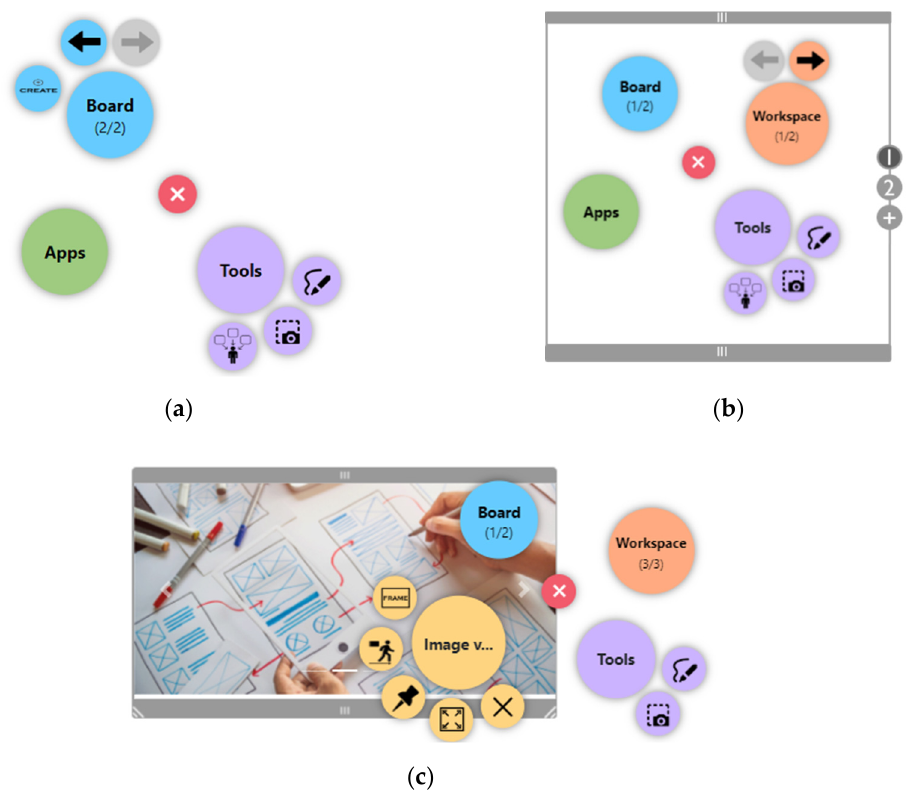
Figure 9. ( a ) Board-specific menu. ( b ) Workspace-specific menu. ( c ) Window-specific menu.